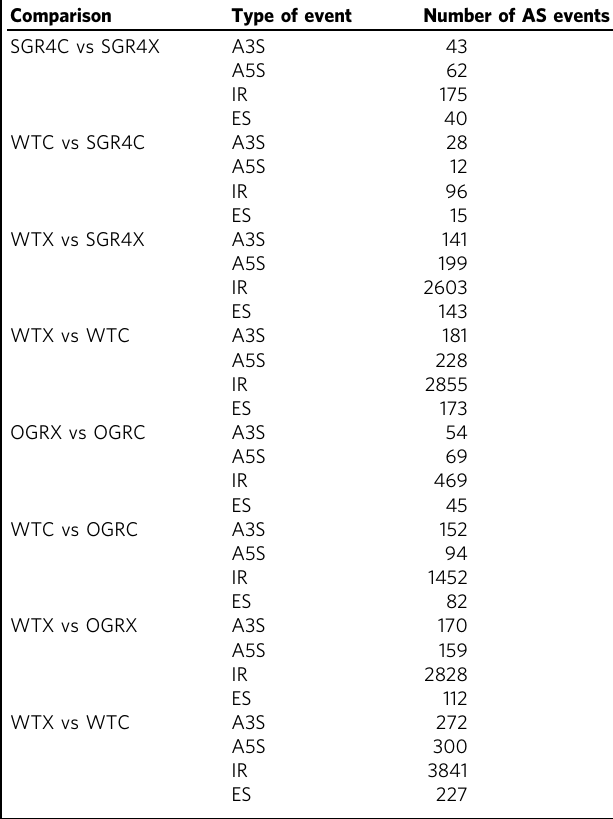
Table 2 Number and type of AS events per